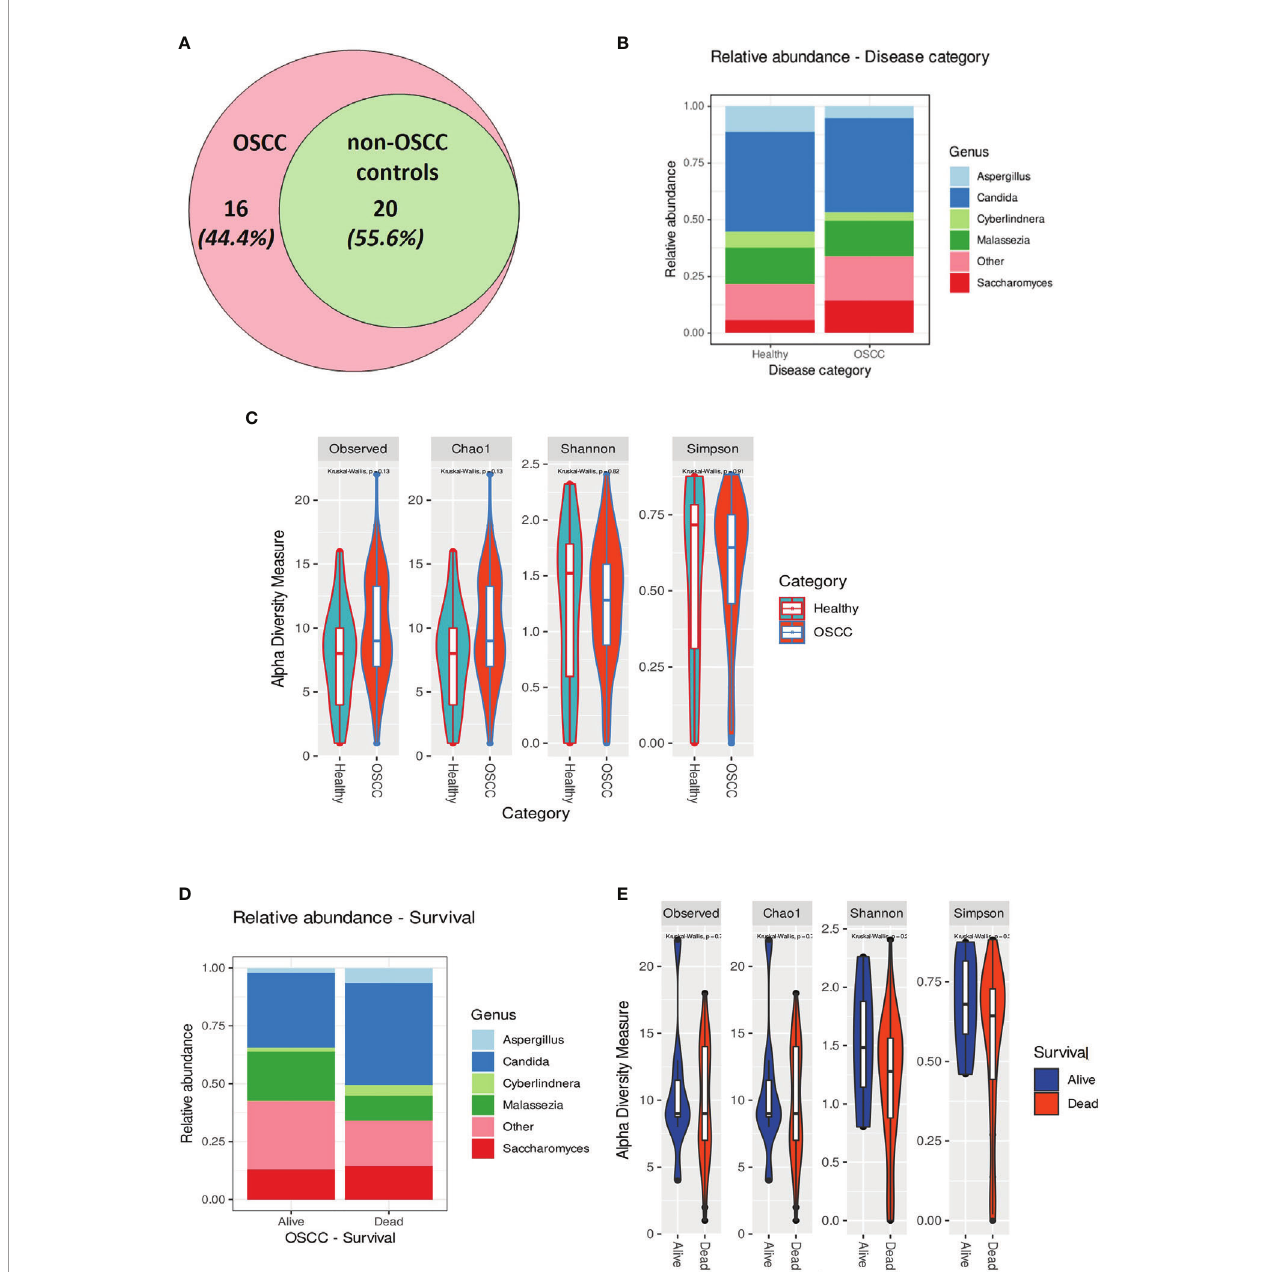
FIGURE 3 | (A) Venn diagram showing the number of genera identi fi ed in the oral squamous cell carcinoma (OSCC) and non-OSCC groups. Those that were found exclusively in the OSCC group were: Macrophomina , Ramularia , Aureobasidium , Alternaria , Ulocladium , Lodderomyces , Meyerozyma , Schizophyllum , Cinereomyces , Phlebiopsis , Rhodosporidiobolus , Rhodotorula glutinis , Filobasidium , Cutaneotrichosporon , unidenti fi ed1 , and unidenti fi ed2 . (B) Relative abundance in the OSCC and non-OSCC groups showing the top fi ve most predominant genera. (C) Alpha rarefaction curve showing the observed features (richness) at different sequencing depths. (D) Relative abundance of individuals (alive and dead) in the OSCC groups showing the top fi ve most predominant genera. (E) Alpha rarefaction curve showing the observed features (richness) at different sequencing depths for OSCC patients strati fi ed by overall survival